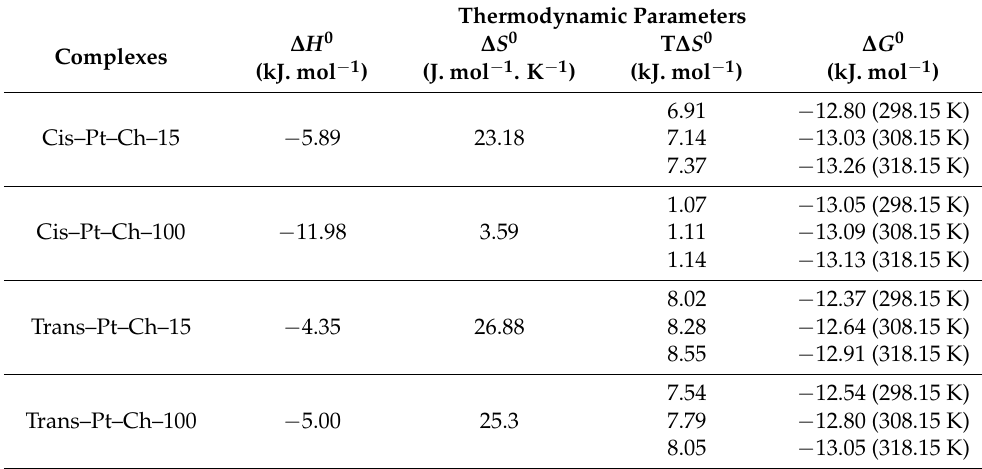
Figure 3. lnK vs. 1/T for chitosan with cis–Pt conjugates: ( A ) Cis–Pt–Ch–15; ( B ) Cis–Pt–Ch–100. Table 2. Thermodynamic parameters for Ch–15 and Ch–100 kD with cis–Pt and